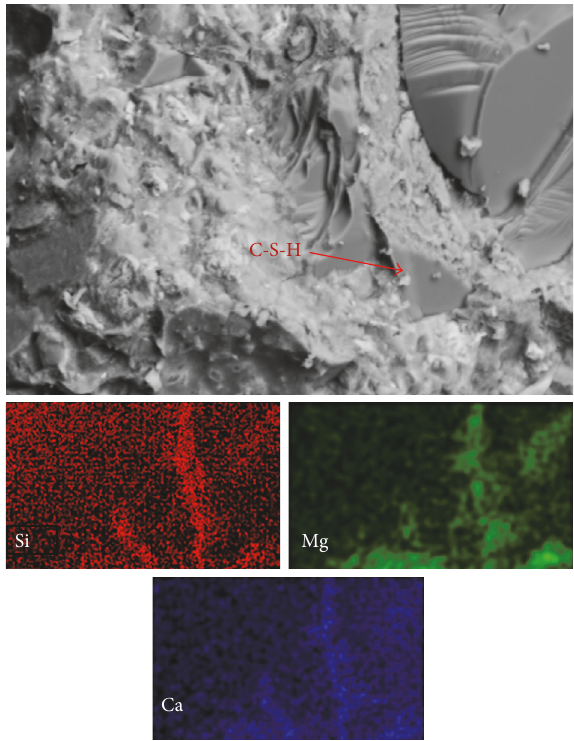
Figure 8: SEM image and its EDAX mapping on Si, Mg, and Ca of SCC-5.